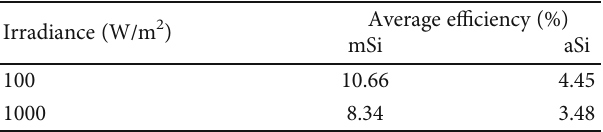
Table 2: Mean e ffi ciency for the two photovoltaic panels. Irradiance (W/m 2